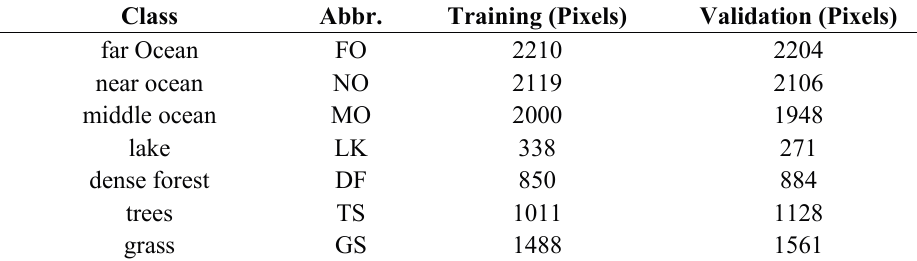
Figure 2. The distribution of the samples shown on the span image. Table 1. Number of Pixels Allocated to Training and Validation Samples in Image